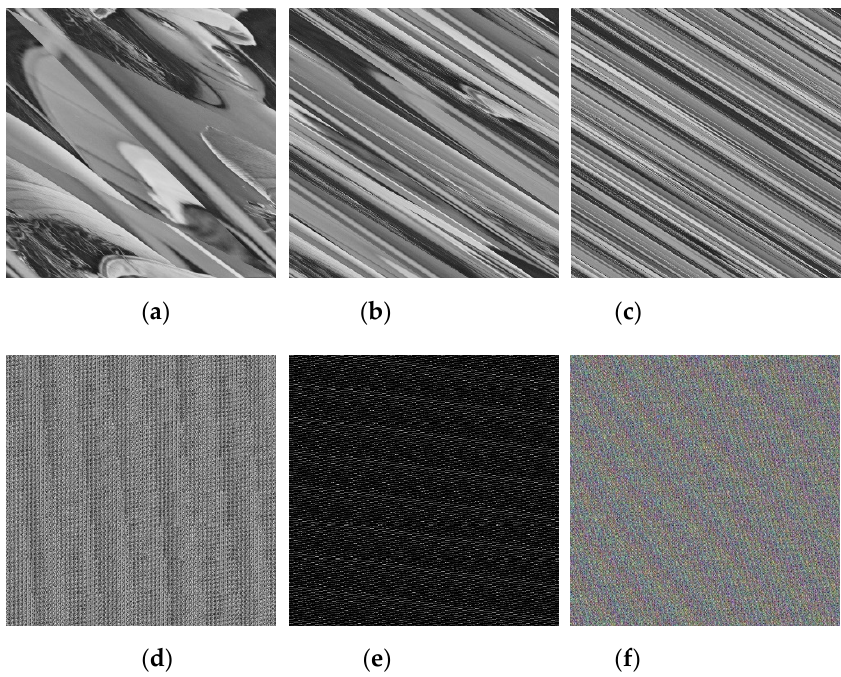
Figure 6. Results of 2D-AT and 3D-AAT: ( a ) One round 2D-AT on 8 BPP Lena; ( b ) Two rounds 2D-AT on 8 BPP Lena; ( c ) Three rounds 2D-AT on 8 BPP Lena; ( d ) One round 3D-AAT on 8 BPP Lena; ( e ) One round 3D-AAT on 16 BPP Lena; ( f ) One round 3D-AAT on 24 BPP Lena. AT is a periodic map, and the period depends on the size of the image. For example,